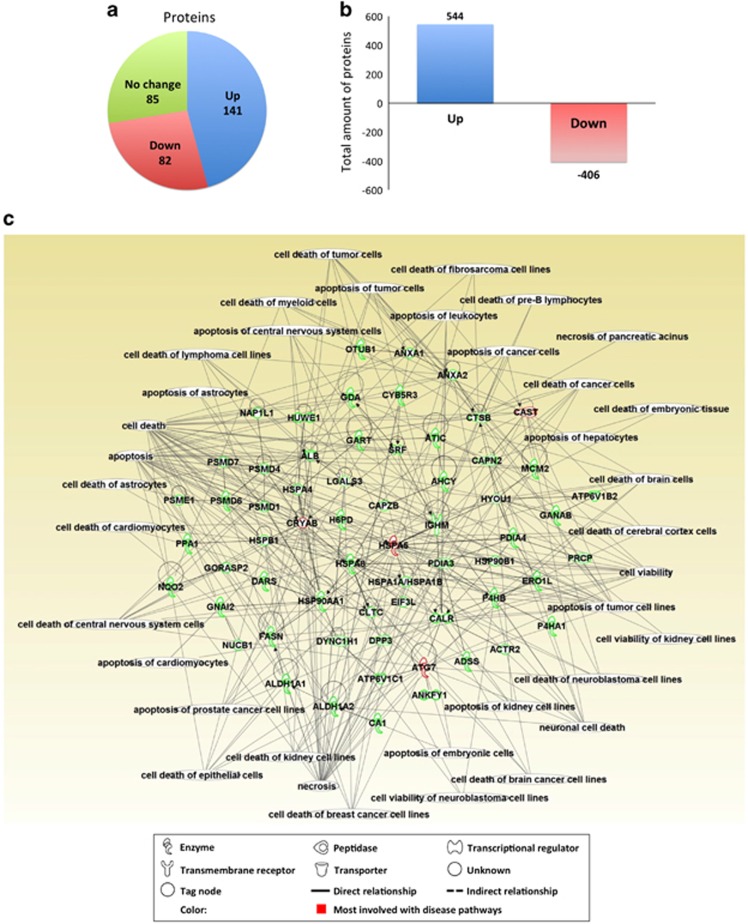
Identification of dysregulated proteins in the KO smooth muscle. LC/MS analysis of KO and WT jejunum (n=3 each) identified total 1531 proteins. The proteins were analyzed using Scaffold and filtered by probability (>95%) and P-value (<0.05) into 308 proteins, which were used for further analysis. (a) Number of dysregulated proteins in KO smooth muscle compared with WT controls. (b) Comparison of amount of dysregulated proteins between WT and KO. (c) Cell death pathway analysis of upregulated proteins. Relationships of upregulated proteins to cell death were analyzed using IPA